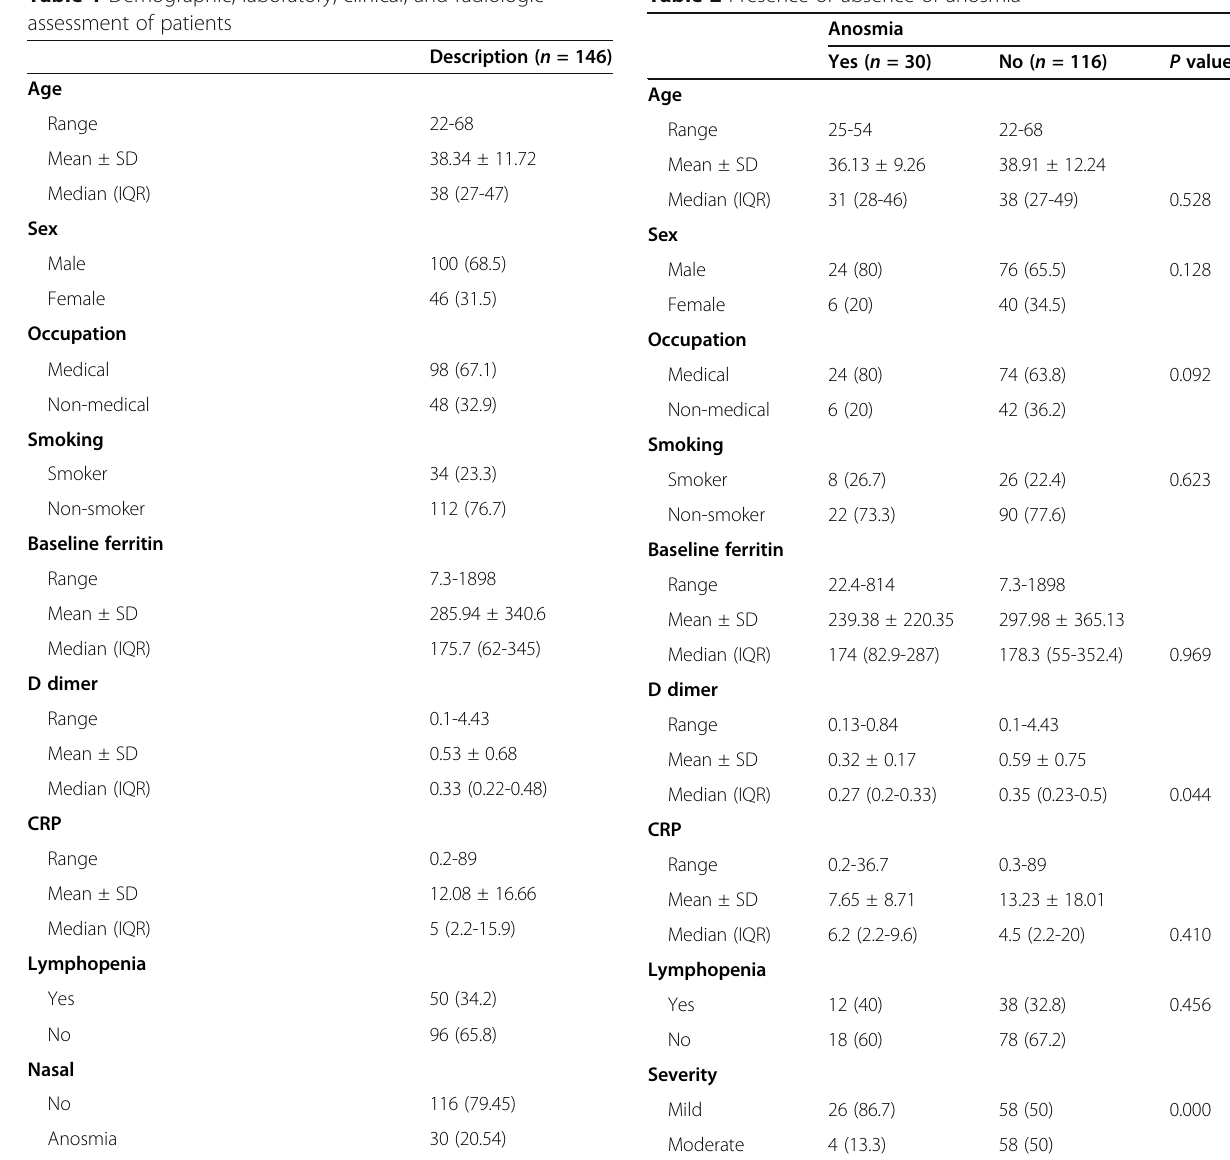
Table 2 Presence or absence of